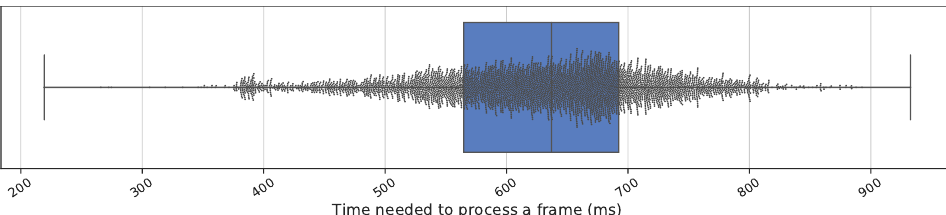
Figure 5. Boxplot of processing time for each frame. A total of 4863 frames from a set of 16 videos were processed to obtain values and to determine the number of workers.